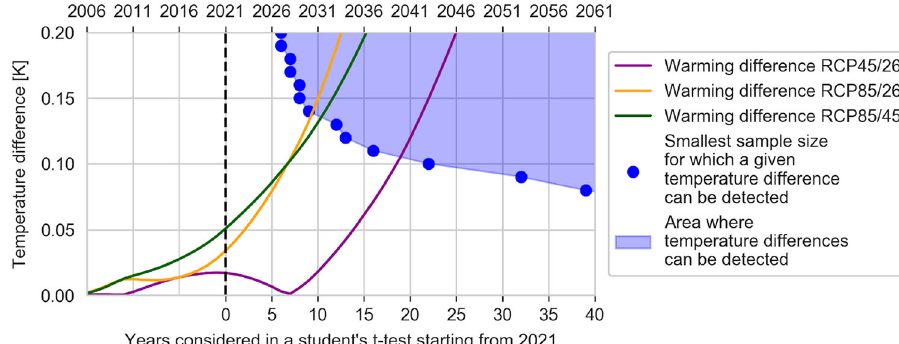
Fig. 1 Detectability of temperature differences using the Samset method. For different constant temperature differences and different sample sizes, a Student ’ s t-test is applied to pairs of annual global mean temperature variability time series from CESM1 LENS 9 . Blue dots indicate the minimal sample size for which a given temperature difference is detected by 66% of the pairs at a 0.05 signi fi cance level, the signi fi cance threshold chosen by Samset et al. 1 The area right of the blue dots is the area for which temperature differences can be detected. Solid lines show emerging warming differences in the forced global mean temperature (GMT) response between different Representative Concentration Pathways (RCPs, from